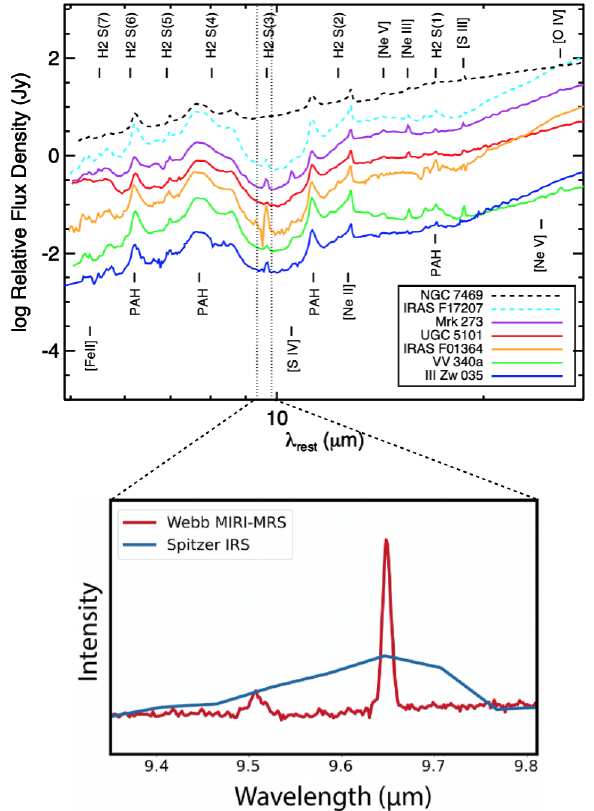
Figure 17. Spitzer /IRS spectra for several (U)LIRGs in GOALS [265]. A full suite of crucial mid- infrared diagnostic lines are accessible and will probe excitation mechanisms, extincted star formation, dust and metal content, and AGN strength and ionization state in typically heavily obscured regions otherwise opaque to optical studies. The spatial and spectral resolutions of the IRS spectra (R ∼ 60–600) will be superseded by MIRI MRS (R ∼ 2500). Dotted vertical lines indicate the spectral region covered by the zoomed-in inset. (Inset) New MIRI MRS engineering calibration spectrum of Seyfert galaxy NGC 6552 (red), shown in comparison with a lower spectral resolution IRS spectrum of a similar galaxy in the same spectral region (blue). The strong emission feature at rest frame 9.66 µ m comes from molecular hydrogen H 2 S(3), while the weaker feature is likely [Fe VII ] λ 9.53 µ m. Inset figure from NASA, ESA, and the MIRI Consortium (courtesy of David Law and Alvaro